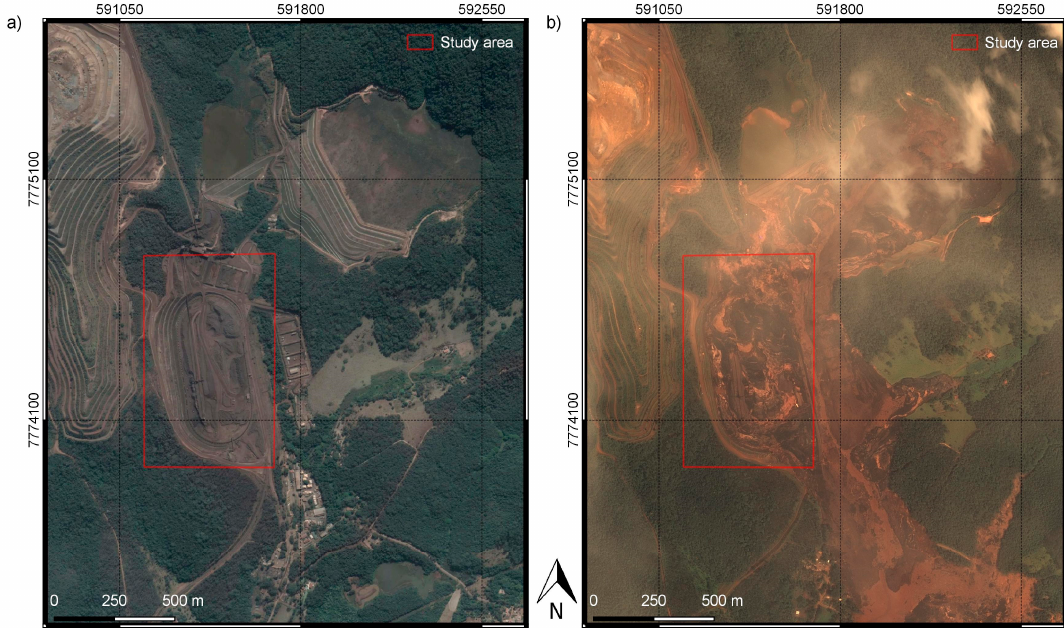
Figure 2. Satellite images show the area of the Córrego do Feijão mine complex in Brumadinho, MG: ( a ) before (21 July 2018) and ( b ) after (27 January 2019) the Brumadinho Dam I collapse.